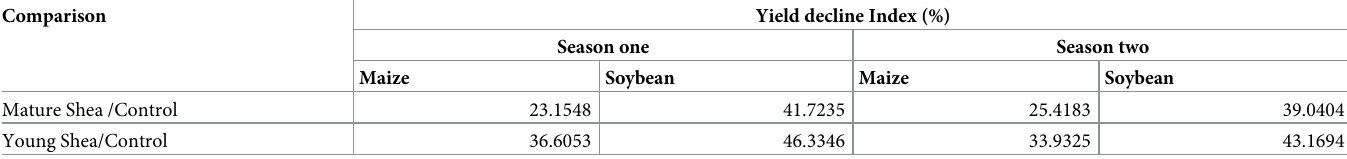
Table 3. Yield decline index of maize and soybean yields from the control under control, mature and young shea. Comparison